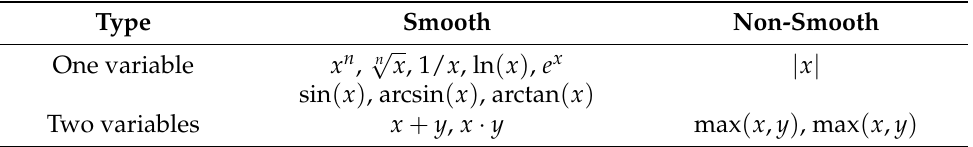
Table 1. Supported elementary